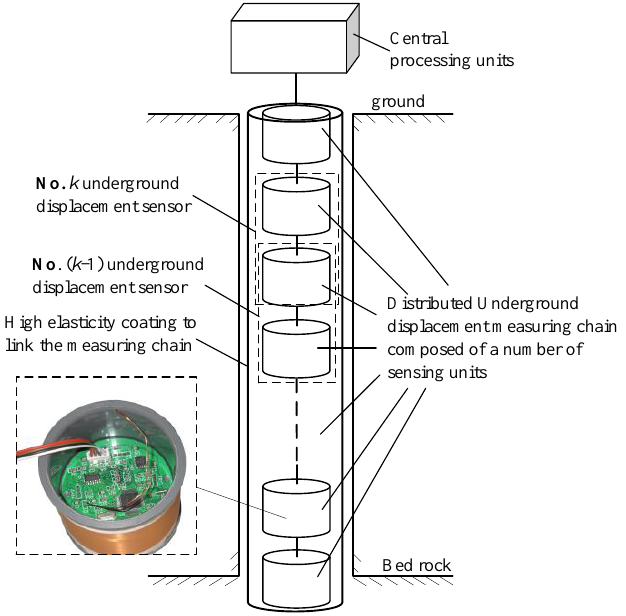
Figure 2. Schematic diagram of the distributed underground displacement measuring apparatus made up of a series of electromagnetic underground displacement